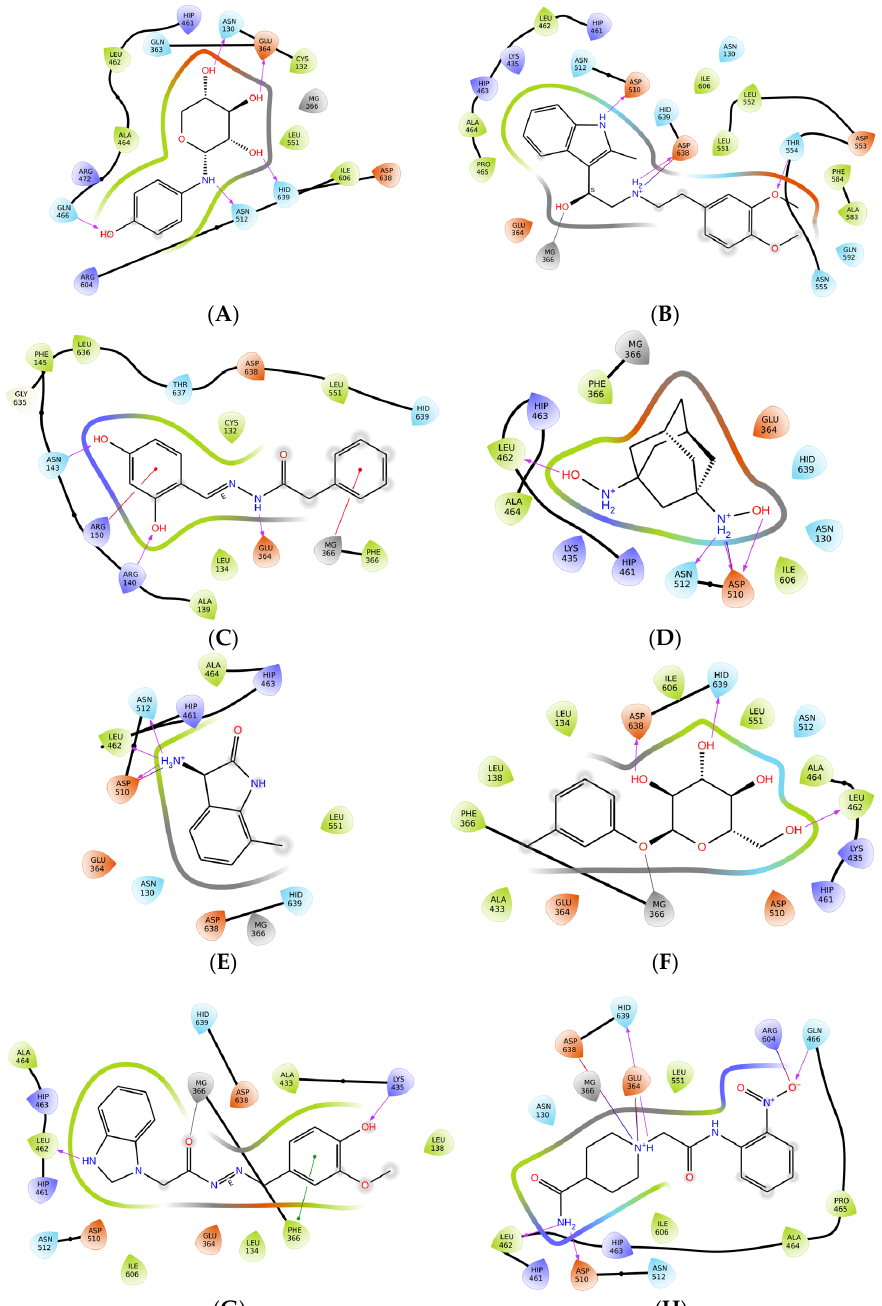
Figure 5. ( A – H ): 2D representation of docking poses after redocking. Shown are the molecules 5728450 (A); 5122895 (B); 5247372 (C); 5150856 (D); 4011505 (E); 5402122 (F); 5784643 (G) and 6924649 (H) interacting with nSMase2 in a 2D representation with polar residues (light blue), negatively charged residues (orange), positively charged residues (dark blue), hydrophobic residues (light green), metals (grey), H-bond (purple arrow), π – π stacking (green lines), π –cation (red lines), solvent exposure (light grey cloud), displaced hydration site (X), salt bridge (blue to red line). Analyses of interactions (see Table 4 below) indicated that all inhibitors except 4011505 showed more interactions with the nSMase2 active site than the two inactives (cf. 5 vs. 4 contacts), yet the activator showed seven contacts, suggesting it to be bound more extensively than the inhibitors. The number of bonds is, however, not in itself sufficient to explain the observed activities. Table 4. Overview and comparison of contacts made between small compounds and nSMase2. Indicated are compounds’ IDs. The residues in nSMase2 that are involved in interaction with the compounds are shown as shaded amino acid abbreviations. Further, the number of observed hy- drogen bonds, salt bridges, metallic interactions, pi-pi interactions, or cation-pi interactions between compounds and nSMase2 are shown, as well as the total number of interactions per compound. For comparison in the bottom line, the residues Asn130, Glu364, Asp510, Asn512, Asp638 and His639 representing conserved active site residues contacting the SM substrate [26] are indicated. ID